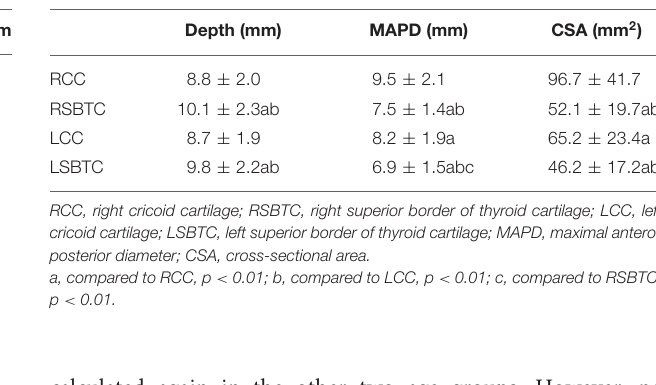
TABLE 2 | The anthropometric values of both internal jugular veins on the levels of cricoid cartilage and superior border of thyroid